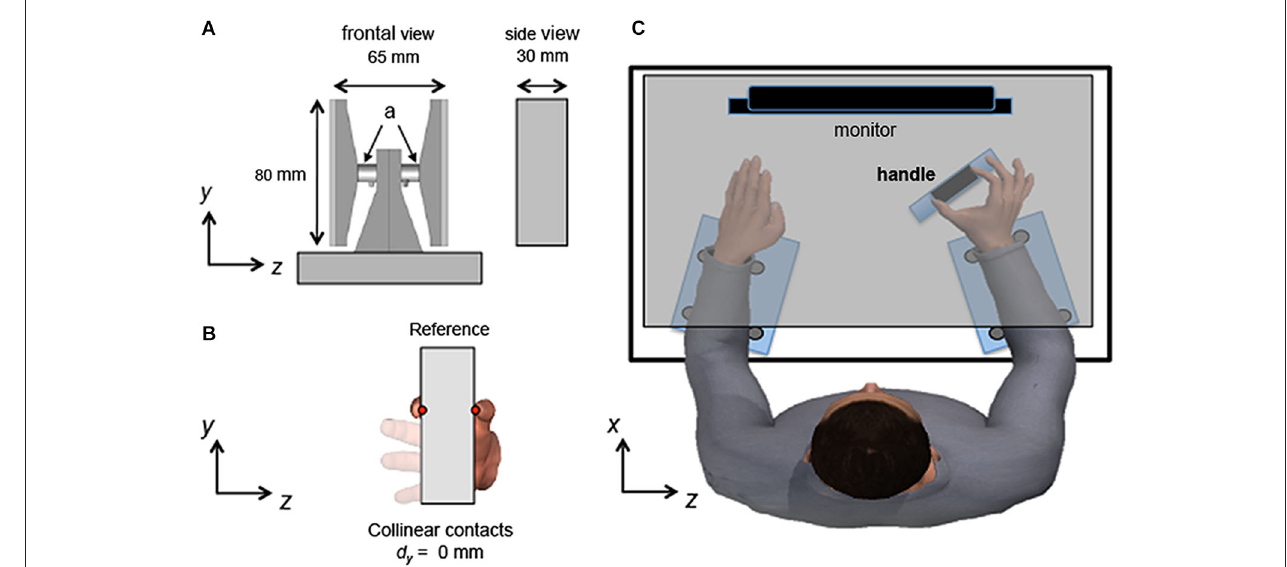
with thumb and index fingertip, while the left hand was kept flat on the table. When relaxing in between trials, both hands were kept flat and relaxed. Note that the table top (gray) was opaque and prevented subjects from seeing their forearms and hands but is shown as transparent for graphical purposes only. Forearms and wrists were strapped to the table to prevent movements within and across trials while the handle was anchored to the